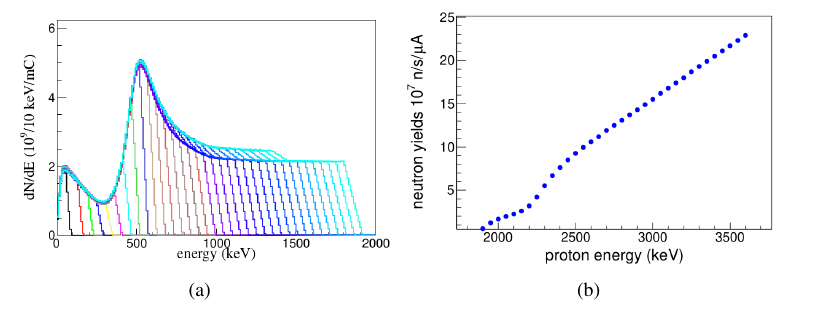
Figure 2. (a) Calculated neutron spectra at the target, for a thick lithium target, and 5 cm 2 target located 2 cm downstream the lithium target. The di ff erent colors represents di ff erent proton beam energies from 1.9 MeV to 3.6 MeV. The neutron spectra were calculated using SimLiT [10]. (b) Total neutron intensity going through the target as function of proton energy. The values are the integration over the spectra in the left